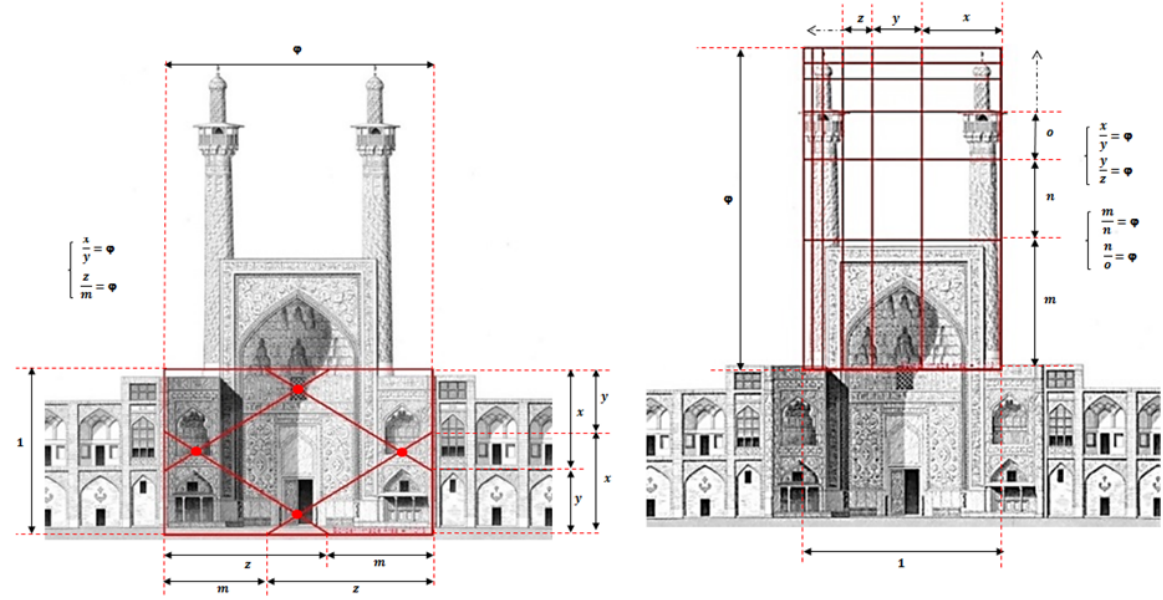
Figure 17: Dividing entrance porch into two golden